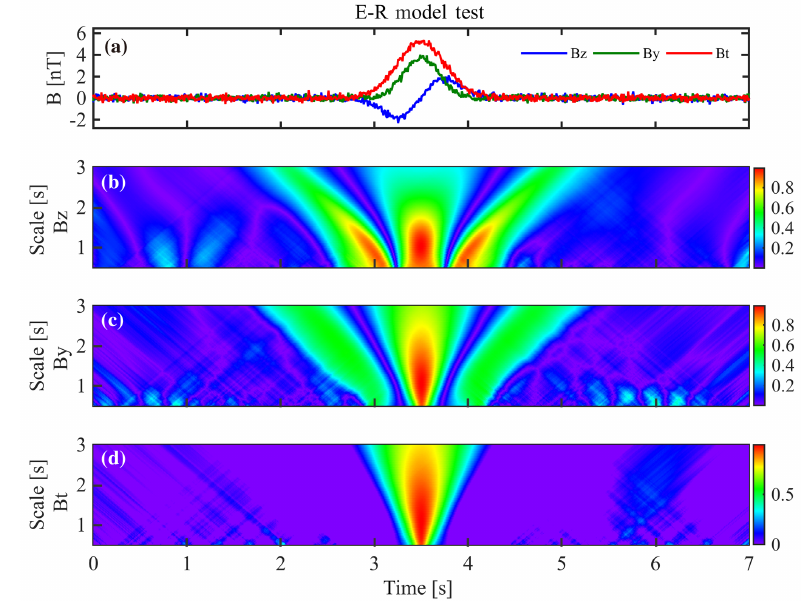
Figure 4. The test results on the E – R model. (a) Three variables B z , B y and B t from E – R model with 10% random noise; (b–d) the correlation coefficients between the variables of B z , B y and B t and the TFC shown in Fig. 3, respectively. The scale on the vertical axes of (b–d) is τ , as mentioned in the text, which can also be seen as a unit.